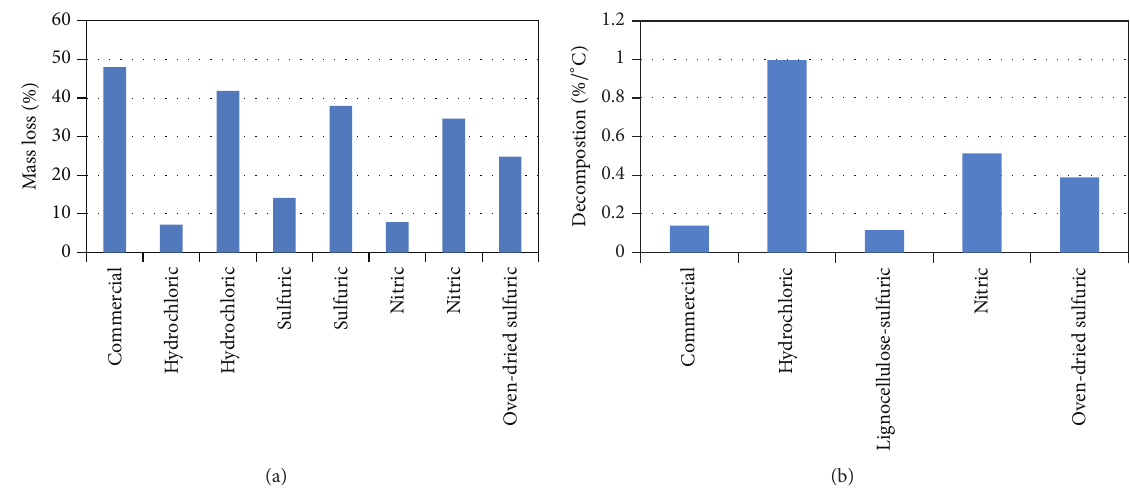
Figure 7: Showing bar graphs of the total percentage of mass loss during water evaporation and decomposition (a) and rate of mass loss during decomposition (b) for cMCC and cellulose extracted from wheat straw, respectively, using acid hydrolysis